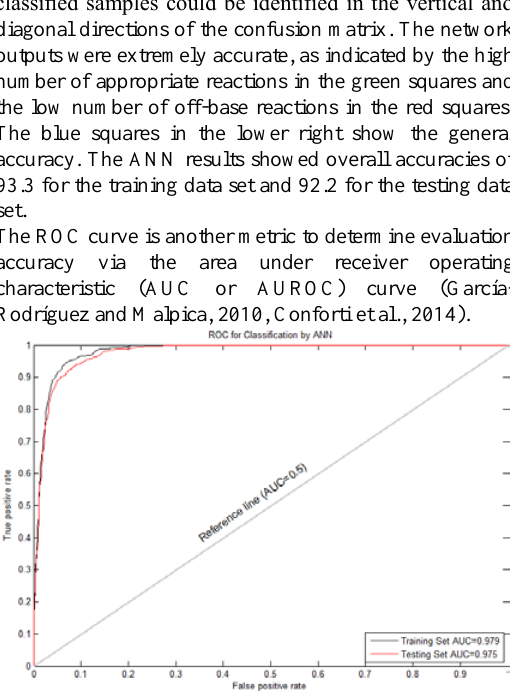
Figure 7. Combination of ROC curves for validation of